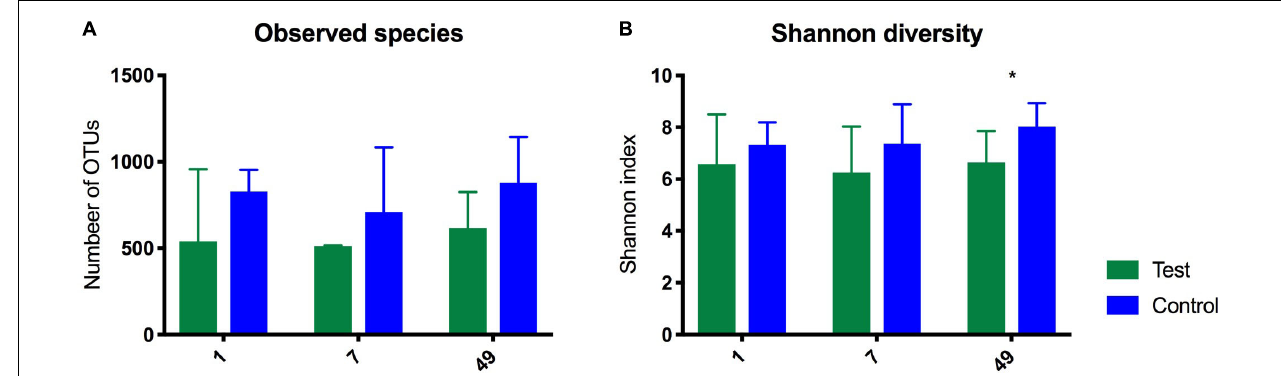
FIGURE 1 | Diagrams showing observed species (A) and Shannon Index (B) as determined by 16S rRNA gene amplicon sequencing in the gut of foals fed either a test supplement enriched with oligosaccharides or a control diet on Day 1, 7, and 49 after birth. Shown as mean +SD of number of observed OTUs (qualitatively) and on the Shannon index (quantitatively). 49 days after birth there was a significant difference on the Shannon index. * P = 0.04.